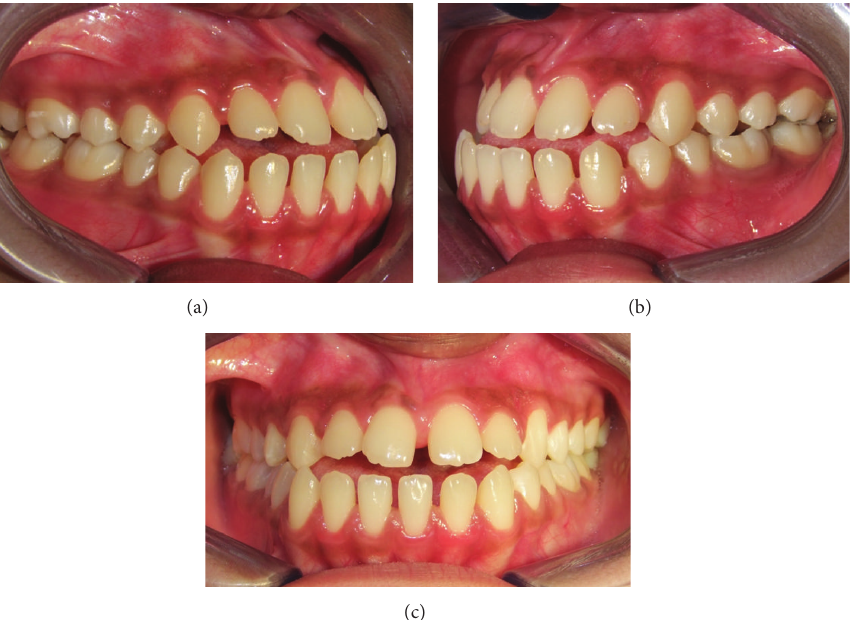
Figure 3: Pretreatment occlusion: (a) right, (b) left, and (c) front.